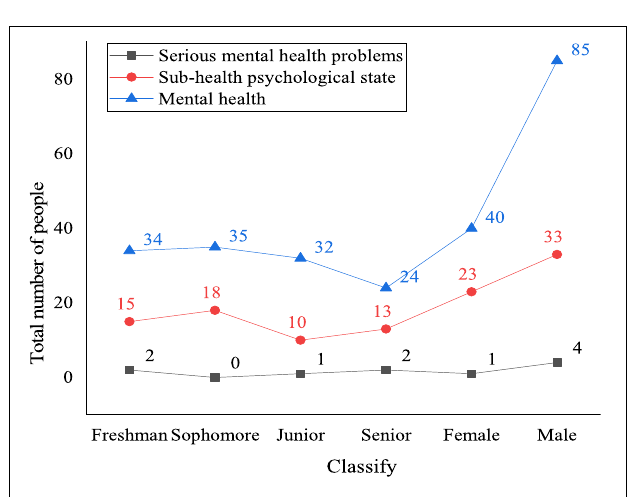
FIGURE 9 | Mental health state of college students in sports majors in Shaanxi Province under the mental health education under big data